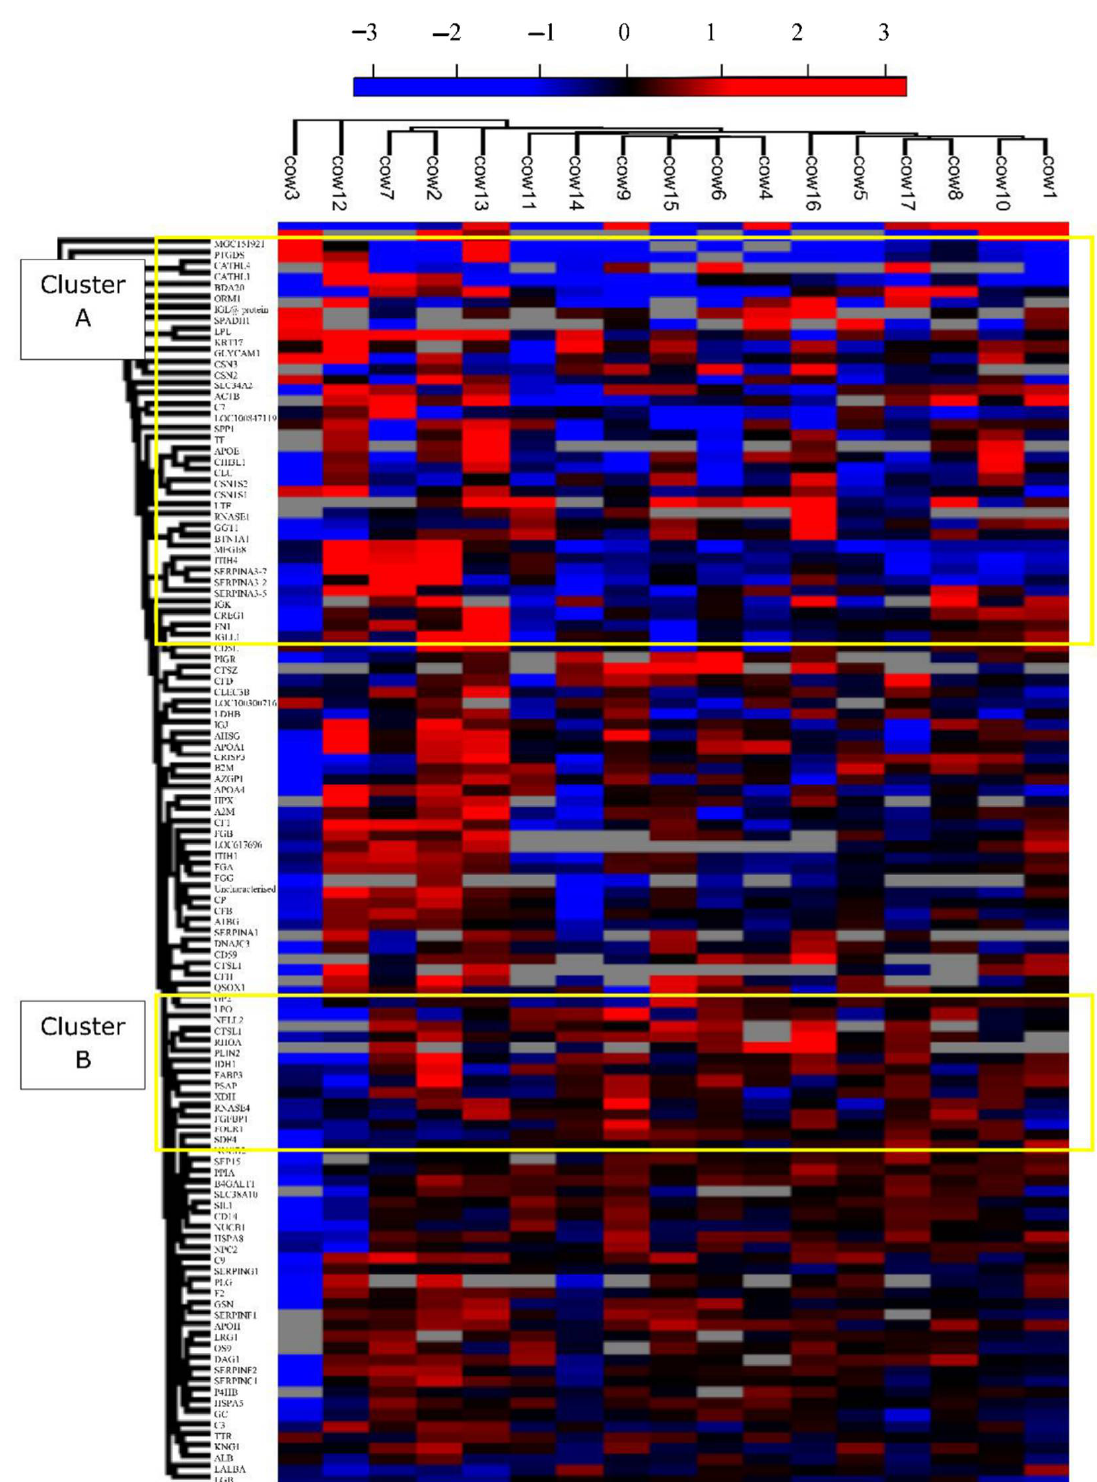
Figure 4. Hierarchical cluster of log 2 ratios of quantified proteins in 17 cows. The log 2 ratio was the abundance of one protein in each cow against the abundance of this protein in the pooled sample; when log 2 ratio was 0, the color was black, when log 2 ratio was more than 0, the color was red and when log 2 ratio was less than 0, the color was blue. The darker the color intensity, the larger the difference between individual cows and the pooled sample. Proteins that could not be quantified are labelled grey; Cluster A are highly varied immune-related proteins, Cluster B are relatively conserved nutrient transport proteins.